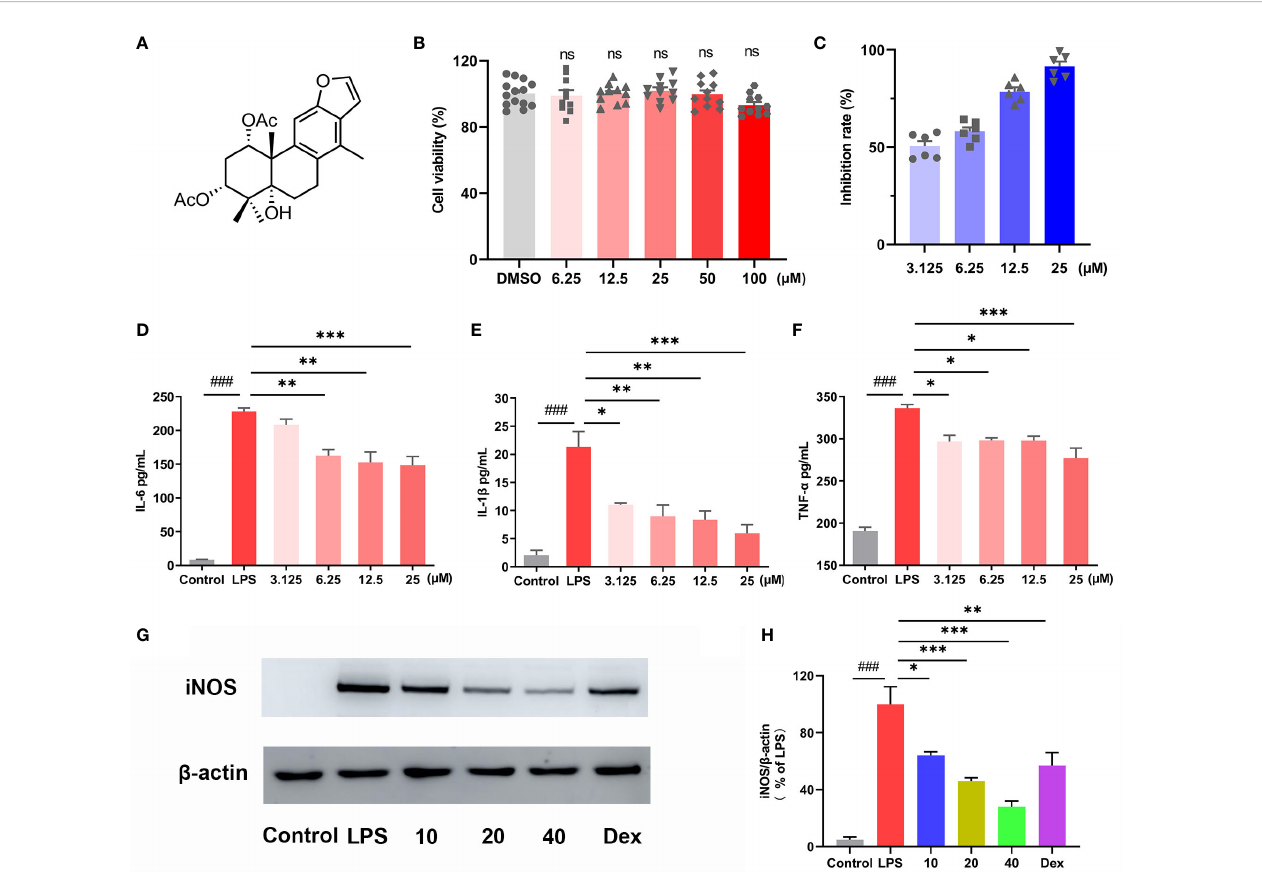
FIGURE 1 CA exhibited anti-in fl ammatory effect in macrophages. (A) Chemical structure of caesaldekarin e (CA). (B) RAW264.7 cells were treated with CA for 24 h as indicated concentrations. The cell viability was determined by MTT assay. (C) RAW264.7 cells were pretreated with the indicated concentration of CA for 2 h, followed by LPS (0.1 m g/mL) stimulation for another 24 (h) Then, the culture medium was collected to determine the nitrite levels using the Griess reagent. RAW264.7 cells were pretreated with the indicated concentration of CA for 2 h, followed by LPS (0.1 m g/mL) stimulation for another 24 (h) The culture medium was collected to determine the levels of IL-6 (D) , IL-1 b (E) and TNF- a (F) by ELISA. (G) RAW264.7 cells were pretreated with CA (10, 20, 40 m M) for 2 h and stimulated with LPS (0.1 m g/mL) for another 12 (h) Then, iNOS protein expression was determined by Western blot analysis. (H) The relative protein expression of iNOS was normalized to b -actin. Data are expressed as the mean ± SEM of three independent experiments. ### P < 0.001 vs. Control group, * P < 0.05, ** P < 0.01, *** P < 0.001 vs. LPS group. ns, no signi fi cant difference with DMSO